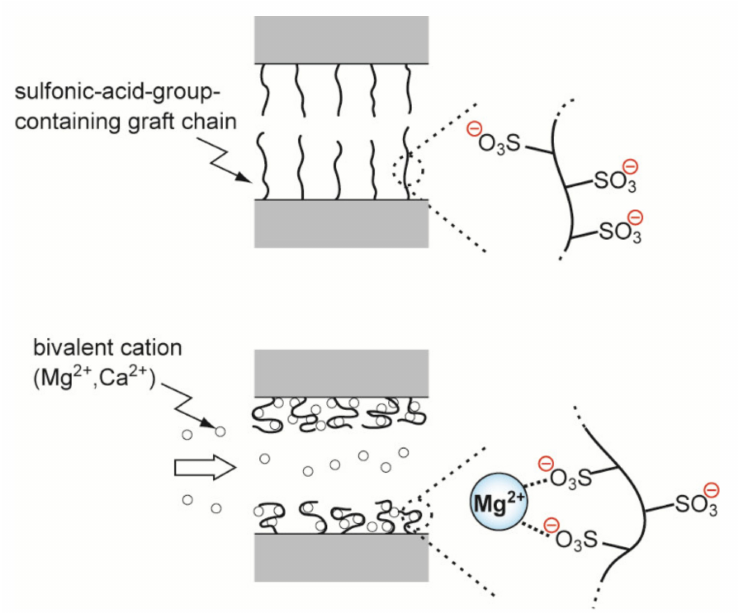
Figure 8. Ionic crosslinking of sulfonic acid-type charged graft chains with magnesium